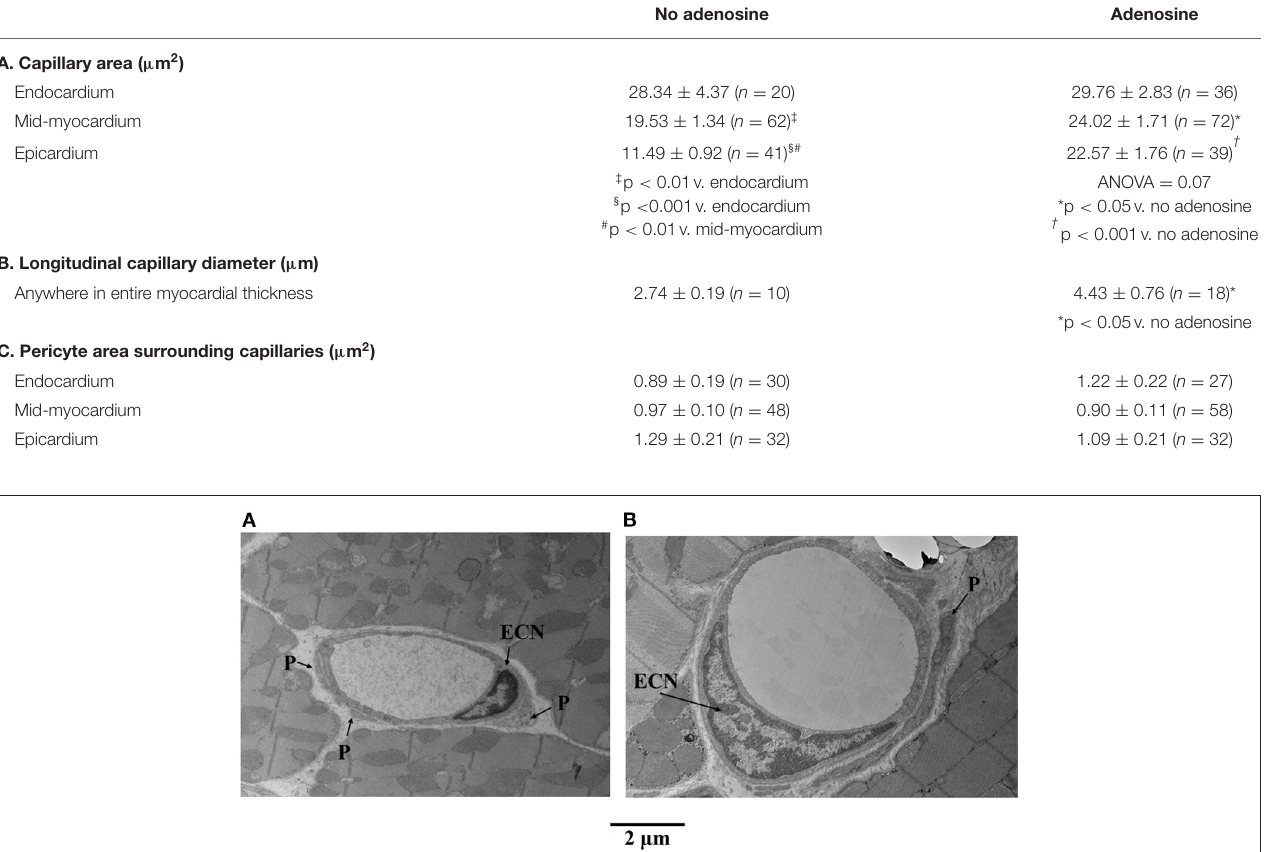
capillary density caused by pericyte contraction in response to reduced